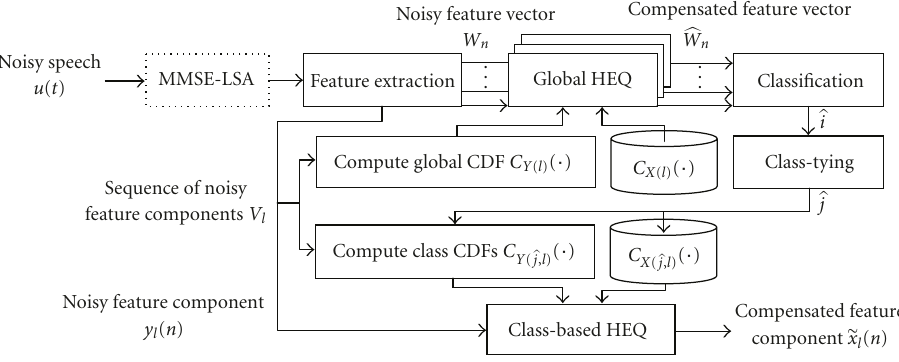
Figure 1: Block diagram of the proposed acoustic mismatch compensation method based on the class-based HEQ with the MMSE-LSA- based speech enhancement.